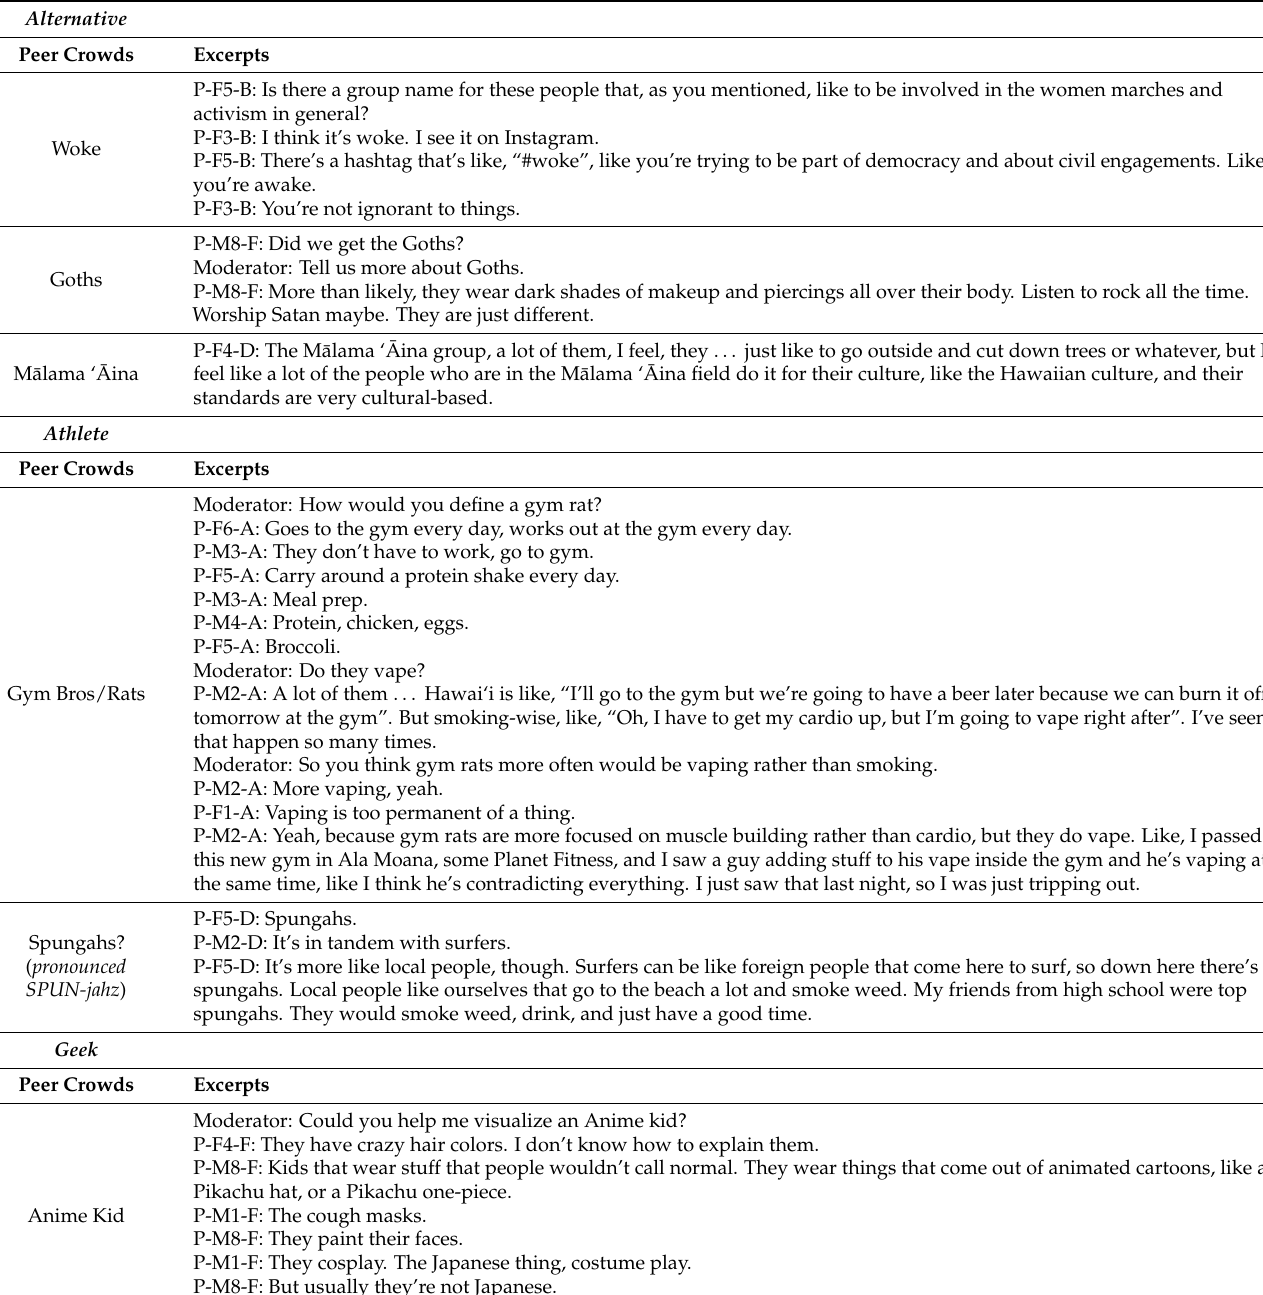
Table 3. Discussion excerpts regarding several peer crowd